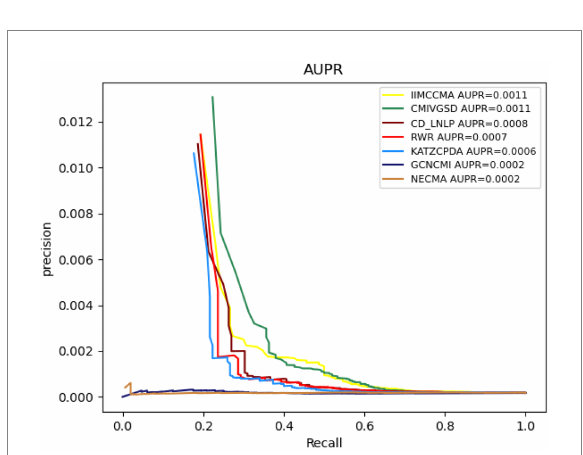
FIGURE 5 Performance comparison between IIMCCMA and other models on dataset 2 in term of AUPR.